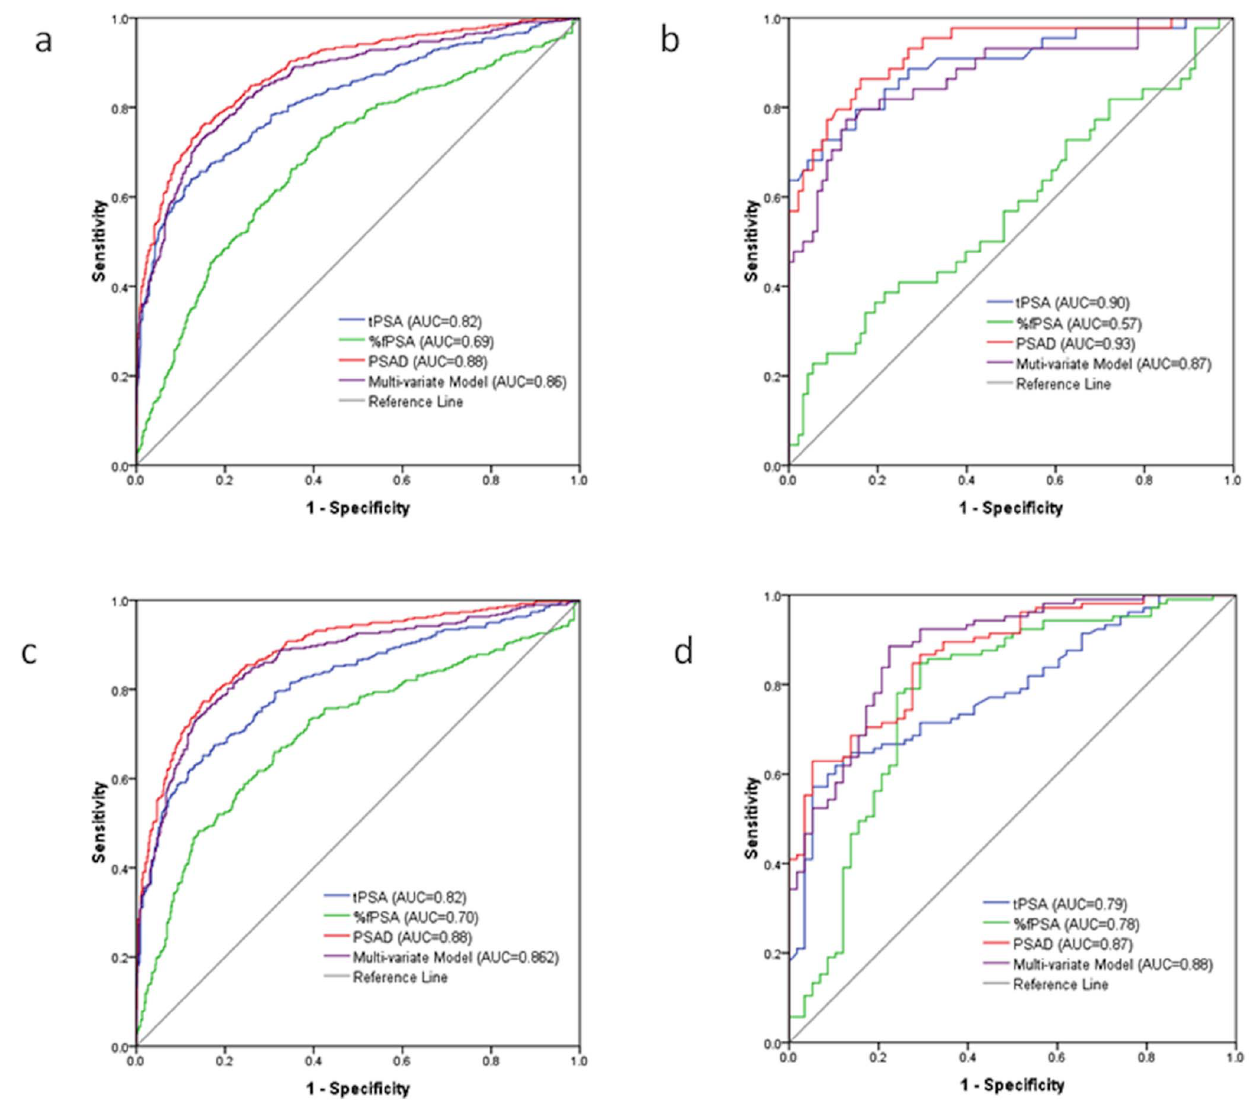
Figure 4. ROC of tPSA, %fPSA, PSAD and multi-variate model (including tPSA, %fPSA and prostate volume) for predicting the result of prostate biopsy for PCa vs. non-PCA in different age groups. (a)All study population: AUC-tPSA vs. AUC-%fPSA (P , 0.001), AUC- PSAD vs. AUC-tPSA(P , 0.001), AUC-model vs. AUC-tPSA(P , 0.001); (b) Age # 60 yr, AUC-tPSA vs. AUC-%fPSA (P , 0.001), AUC-PSAD vs. AUC- tPSA(P . 0.05), AUC-model vs. AUC-tPSA(P . 0.05); (c) Age 61–80 yr, AUC-tPSA vs. AUC-%fPSA (P , 0.001), AUC-PSAD vs. AUC-tPSA(P=0.001), AUC- model vs. AUC-tPSA(P=0.02); (d) Age $ 81 yr, AUC-tPSA vs. AUC-%fPSA (P . 0.05), AUC-PSAD vs. AUC-tPSA(P . 0.05), AUC-model vs. AUC- tPSA(P=0.03). doi:10.1371/journal.pone.0067585.g004 old (Figure 4c). Significant difference was observed between multi- Figure 5, and Figure 6, respectively . Men with missing data (n =630) were excluded from ROC analysis. When predicting varitate model (AUC = 0.88) and tPSA (AUC = 0.79, P =0.03) (or PCa vs. non-PCa in the whole study population, the AUCs of %fPSA, P= 0.02) when predicting PCa vs. non-PCa in men $ 81 PSAD and multi-variate model were 0.88 and 0.86, which was years old ( Figure 4d ). No significant differences between tPSA significantly higher than the AUCs of tPSA (AUC = 0.82, all and PSAD (or multi-variate model) were found in any of the age P , 0.010) and %fPSA (AUC =0.69, P , 0.001). The AUC of tPSA groups (P . 0.05) when predicting Gleason Score $ 7 PCa vs. was significantly higher than the AUC of %fPSA (P , 0.01) ( Figure 4 a ). When predicting PCa vs. non-PCa in men # 60 Gleason Score , 8 plus non-PCa ( Figure 5 and Figure 6 ). In years old, there was no significant difference between the AUC of addition, tPSA, PSAD, %fPSA and multi-variate model performed PSAD (AUC = 0.93) (or AUC of multi-variate model, AUC = 0.87) and the AUC of tPSA (AUC =0.90), however, their Gleason Score $ 7 PCa vs. Gleason Score , 7 plus non-PCa or AUCs were higher than the AUC of %fPSA (AUC= 0.57) Gleason Score $ 8 PCa vs. Gleason Score , 8 plus non-PCa ( Figure 4 b ). Significant differences were observed between tests (P . 0.05) ( Figure 5 and Figure 6 ). (P , 0.01) when predicting PCa vs. non-PCa in men 61 to 80 years